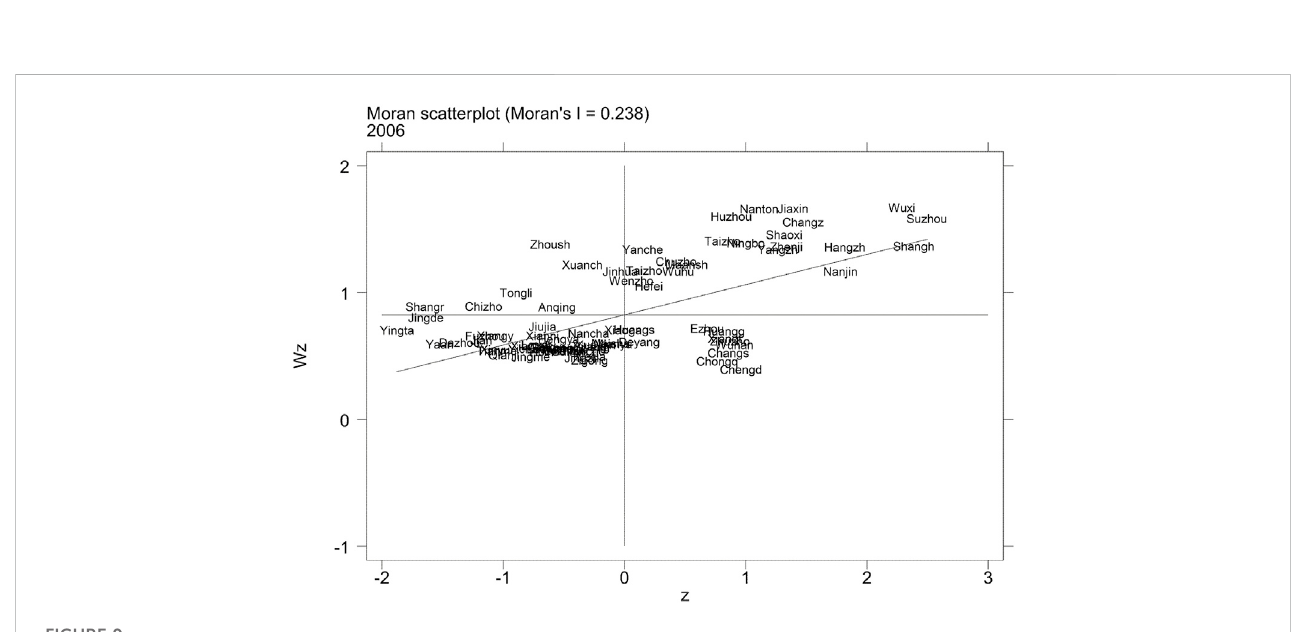
FIGURE 9 Local Moran index scatter plot in